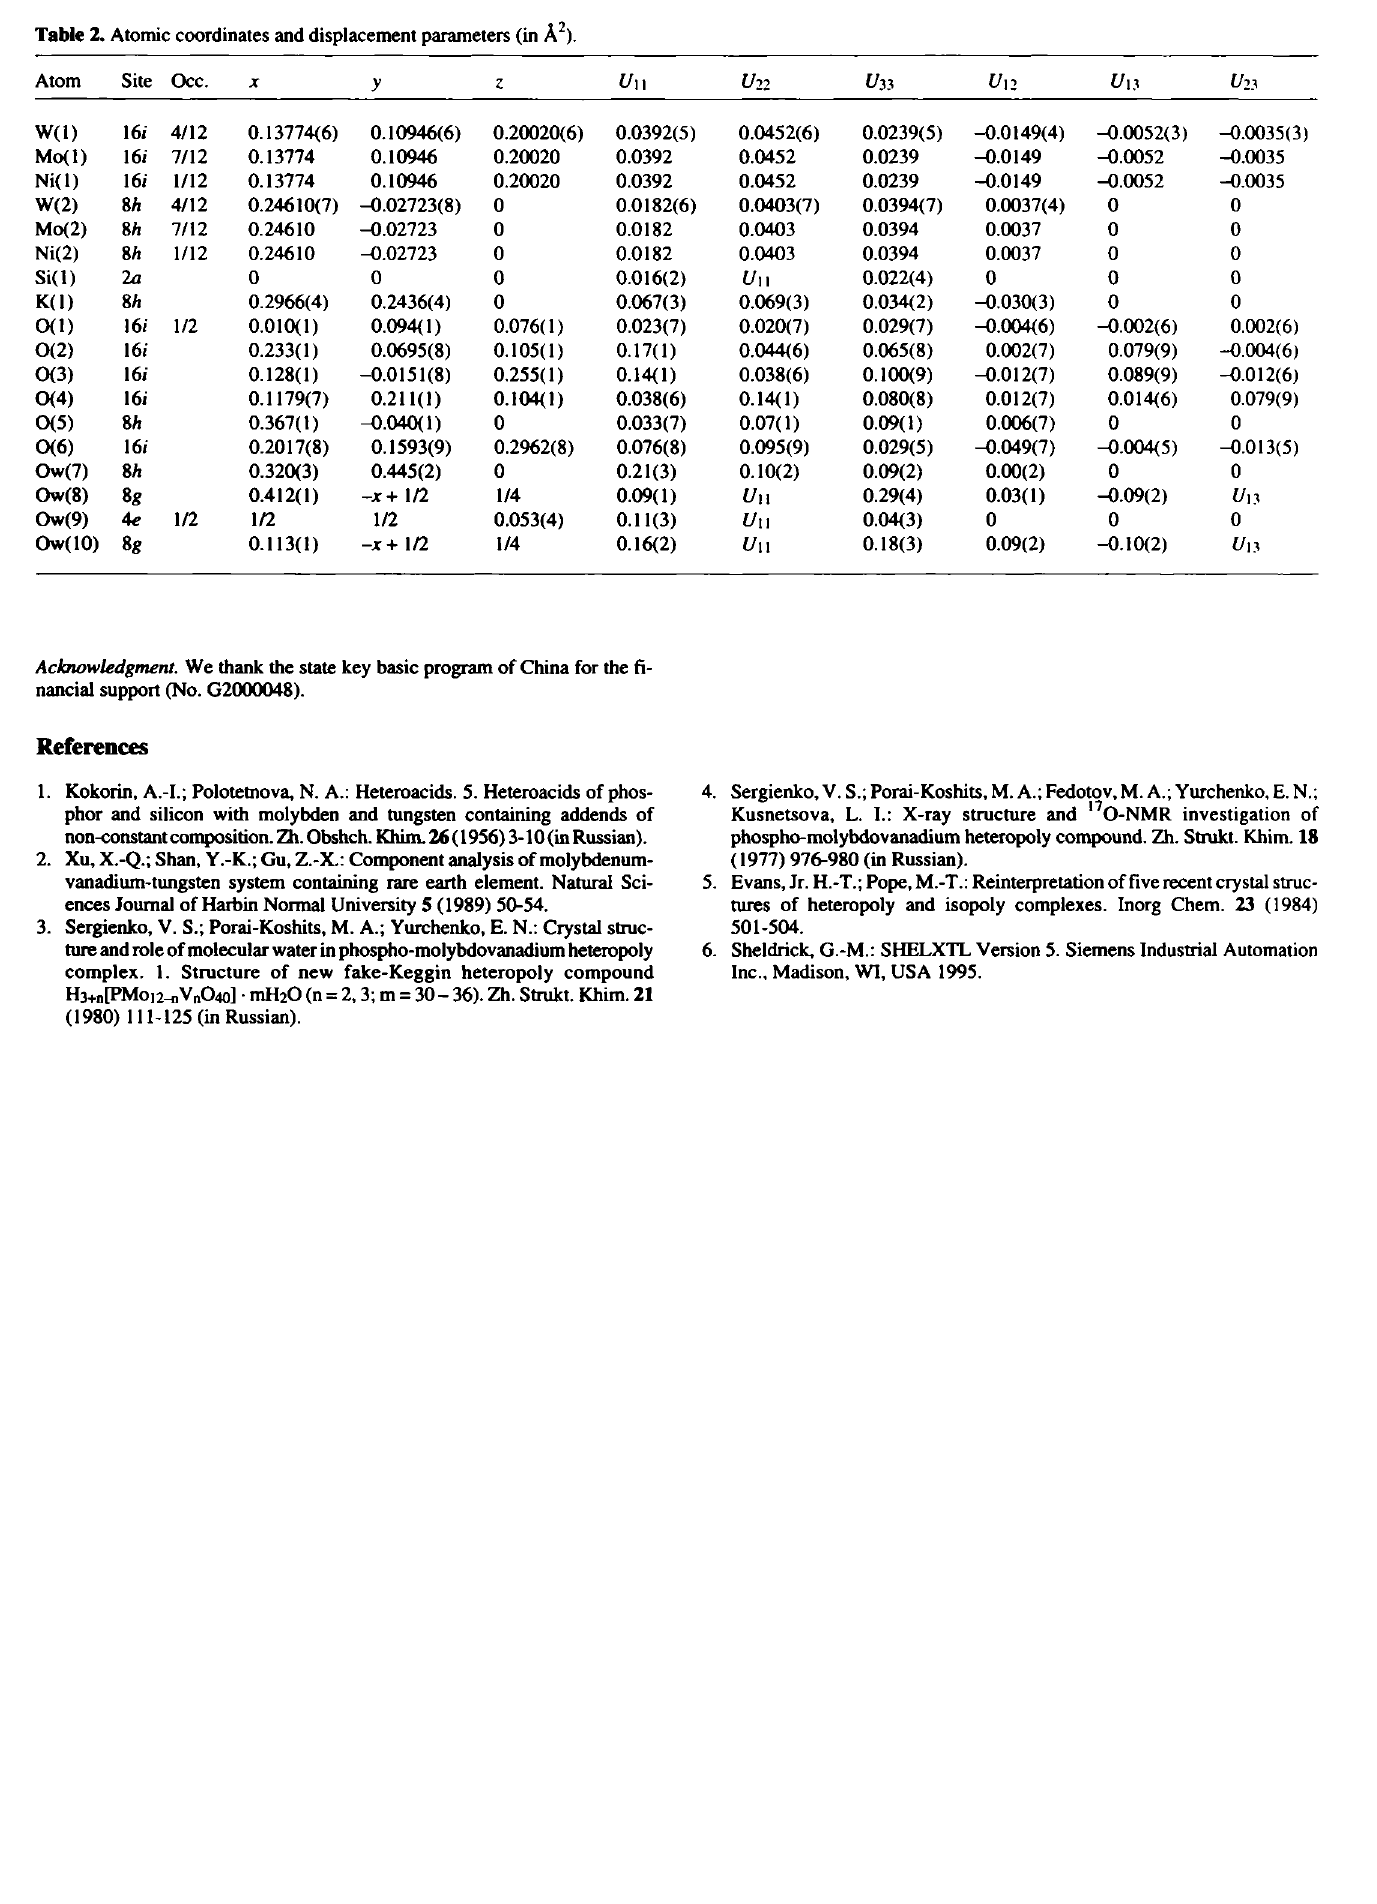
Table 2. Atomic coordinates and displacement parameters (in Â 2 ). Atom Site